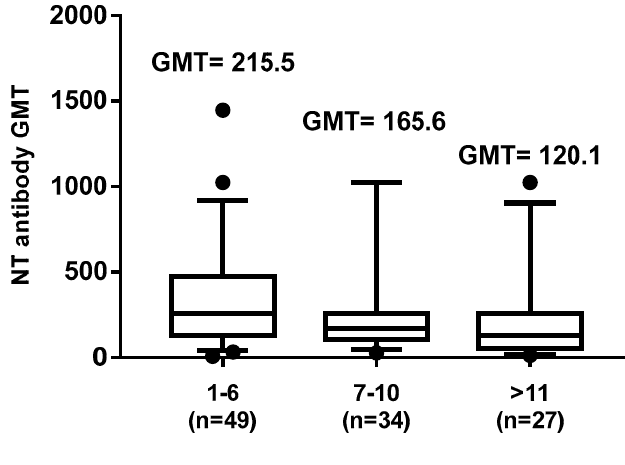
Figure 6. Effect of time elapsed between the two doses of measles vaccine on the neutralizing antibody response. The whiskers represent the values from the 5th to the 95th percentiles; the median, the 25th and 75th percentiles are depicted by the horizontal lines in the boxes. Individual data points are shown; outlier values are shown as black circles or squares. GMTs are shown above the population columns. The difference in GMTs between the first (1–6) and the third ( ≥ 11) group is statistically significant ( p ≤ 0.05).